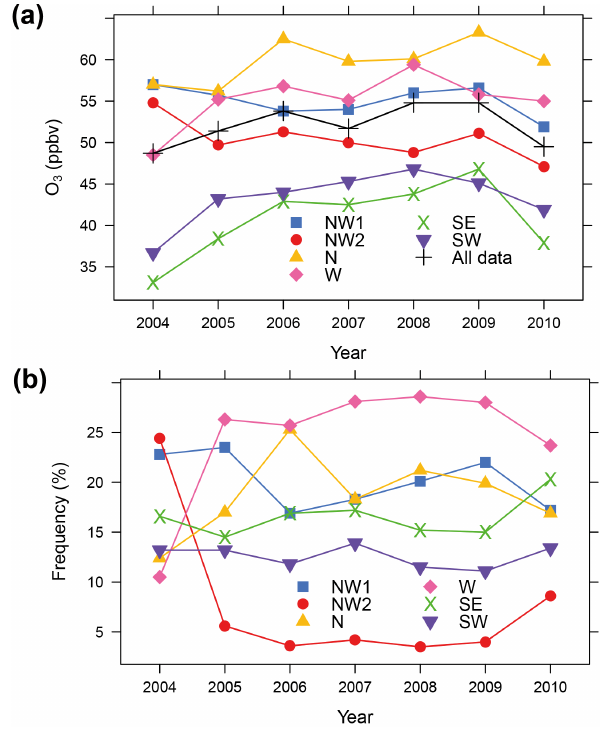
Figure 10. Annual variations of (a) O 3 concentrations for six clus- ters and (b) their